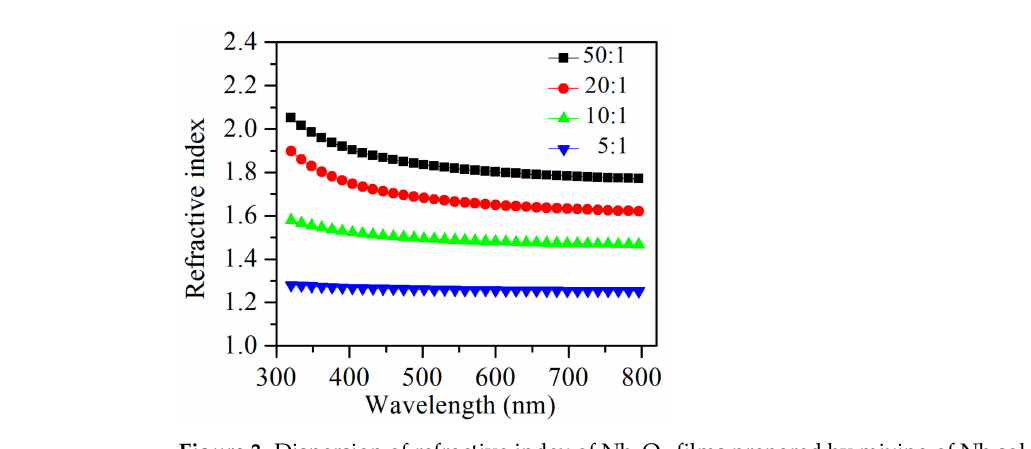
Figure 3. Dispersion of refractive index of Nb 2 O 5 films prepared by mixing of Nb sol and colloidal solution of nanoparticles of SiO 2 in different volume fractions indicated in the figure.